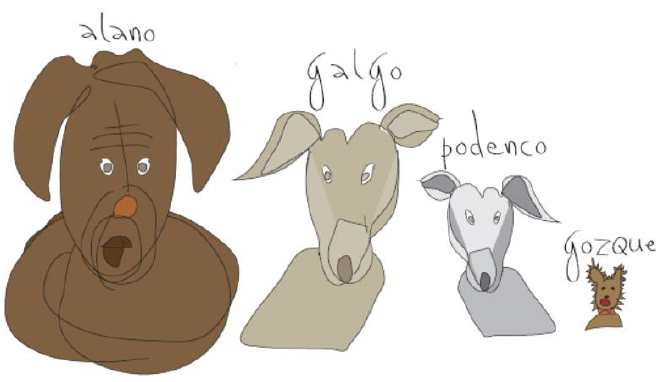
Figure 4. Tamara Schneider, Dog breeds in Don Quixote . © 2017 Tamara Schneider. Used with permission.